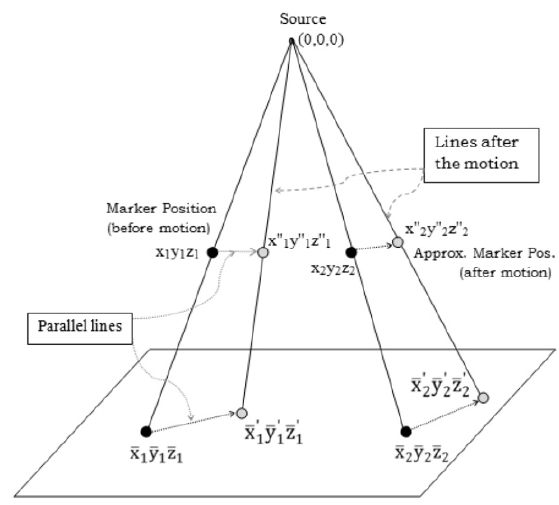
Figure 17. Approximate coordinates of two markers after